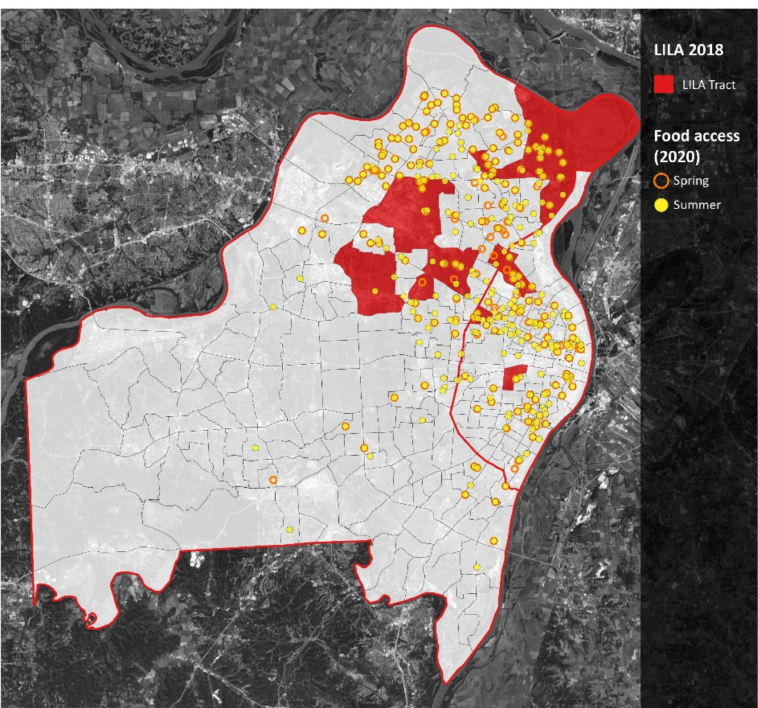
Figure 9. Meal access in low-income and low-access census tracts. Notes: St. Louis City is the area east of the red line. St. Louis County is the area west of the red line. Low-income-low-access (LILA) census tracts are in red. Orange circles represent spring meal sites; yellow dots represent summer meal